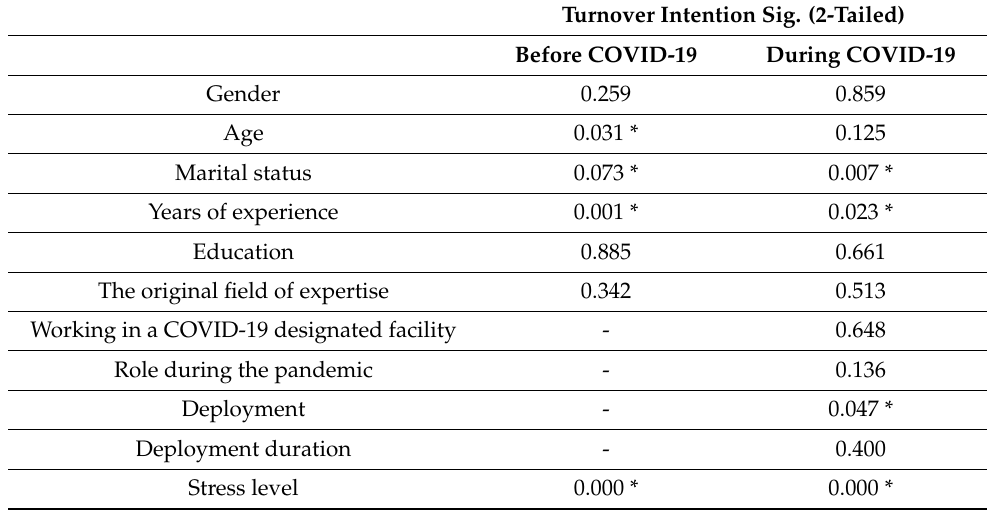
Table 3. Comparison of TO intentions before and during